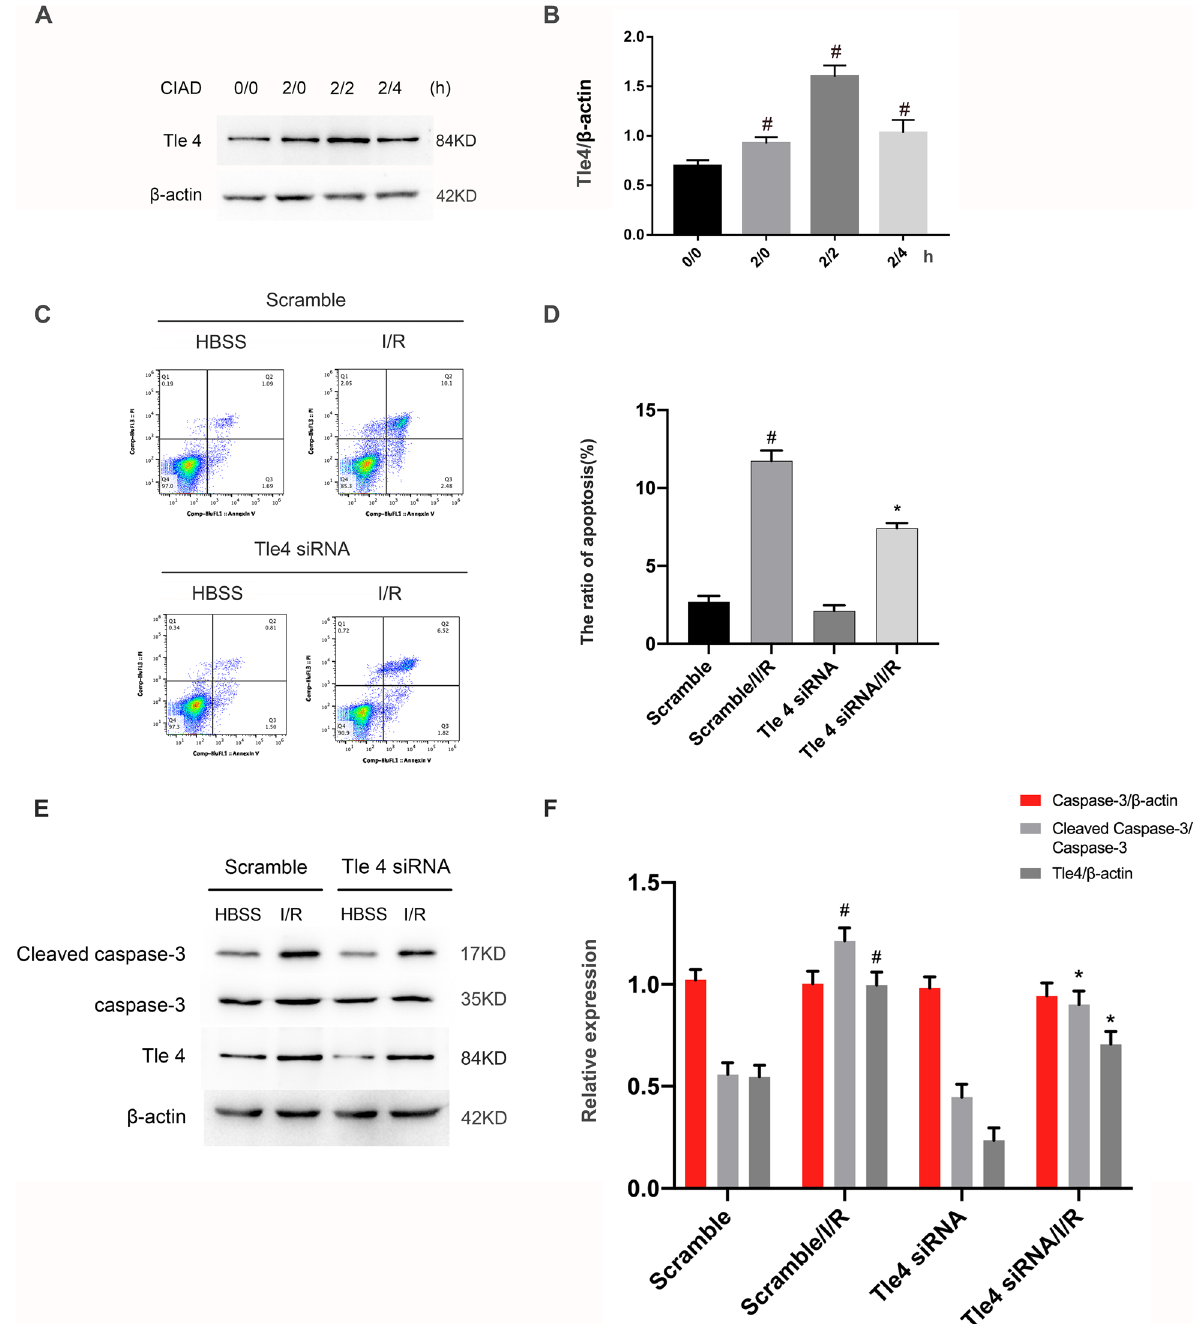
Fig. 7 Inhibition of Tle4 ameliorated I/R-induced apoptosis of RGCs. RGCs were transfected with 50 nmol/L Tle4 siRNA or scramble and then treated with or without I/R damage. A , B RGCs were treated with or without I/R at indicated time points (ischemia/reperfusion for 0/0, 2/0, 2/2, 2/4 h, respectively). The expression levels of Tle4 were detected by Western blot. C , D Representative data from the flow cytometric analysis of total cell apoptosis. The Q1 region represents necrotic cells, the Q2 region represents late apoptotic cells, the Q3 region represents early apoptotic cells, and the Q4 region represents normal cells. E , F Representative image and quantitative analysis of Western blot of cleaved caspase-3, caspase-3, and Tle4. Data are expressed as mean SD (n 6). # p < 0.05, I/R for 0/0, 2/0, 2/2, 2/4 h versus 0/0 h, scramble with I/R group versus scramble group; * p < 0.05, ± = Tle4 siRNA group with I/R group versus scramble with I/R